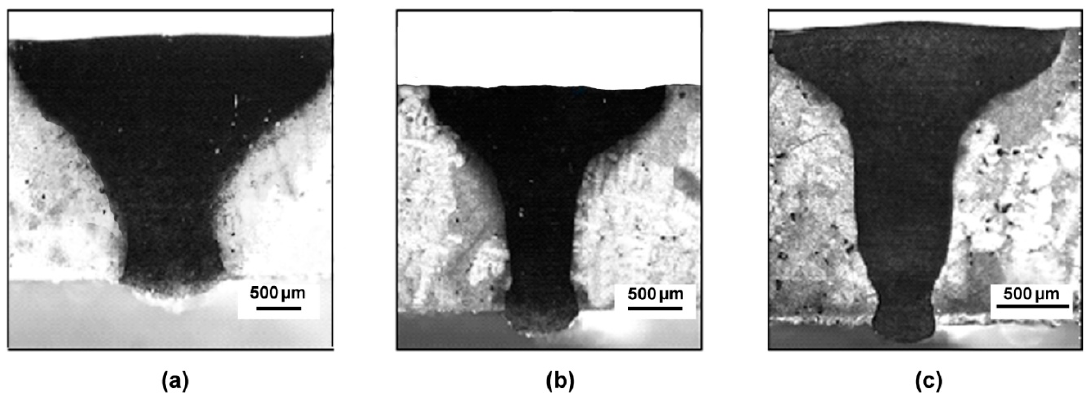
Figure 7. Cross-sections of the seams obtained by EB welding with PHT = 300 °C: pass speed of 1.5 m/min ( a ); 2.0 m/min ( b ) and 2.5 m/min ( c ). Table 2. Maximum width w and aspect ratio p/w (p: depth, w: maximum width) of the joints in different conditions of welding pass speed and pre-heating temperature (PHT).